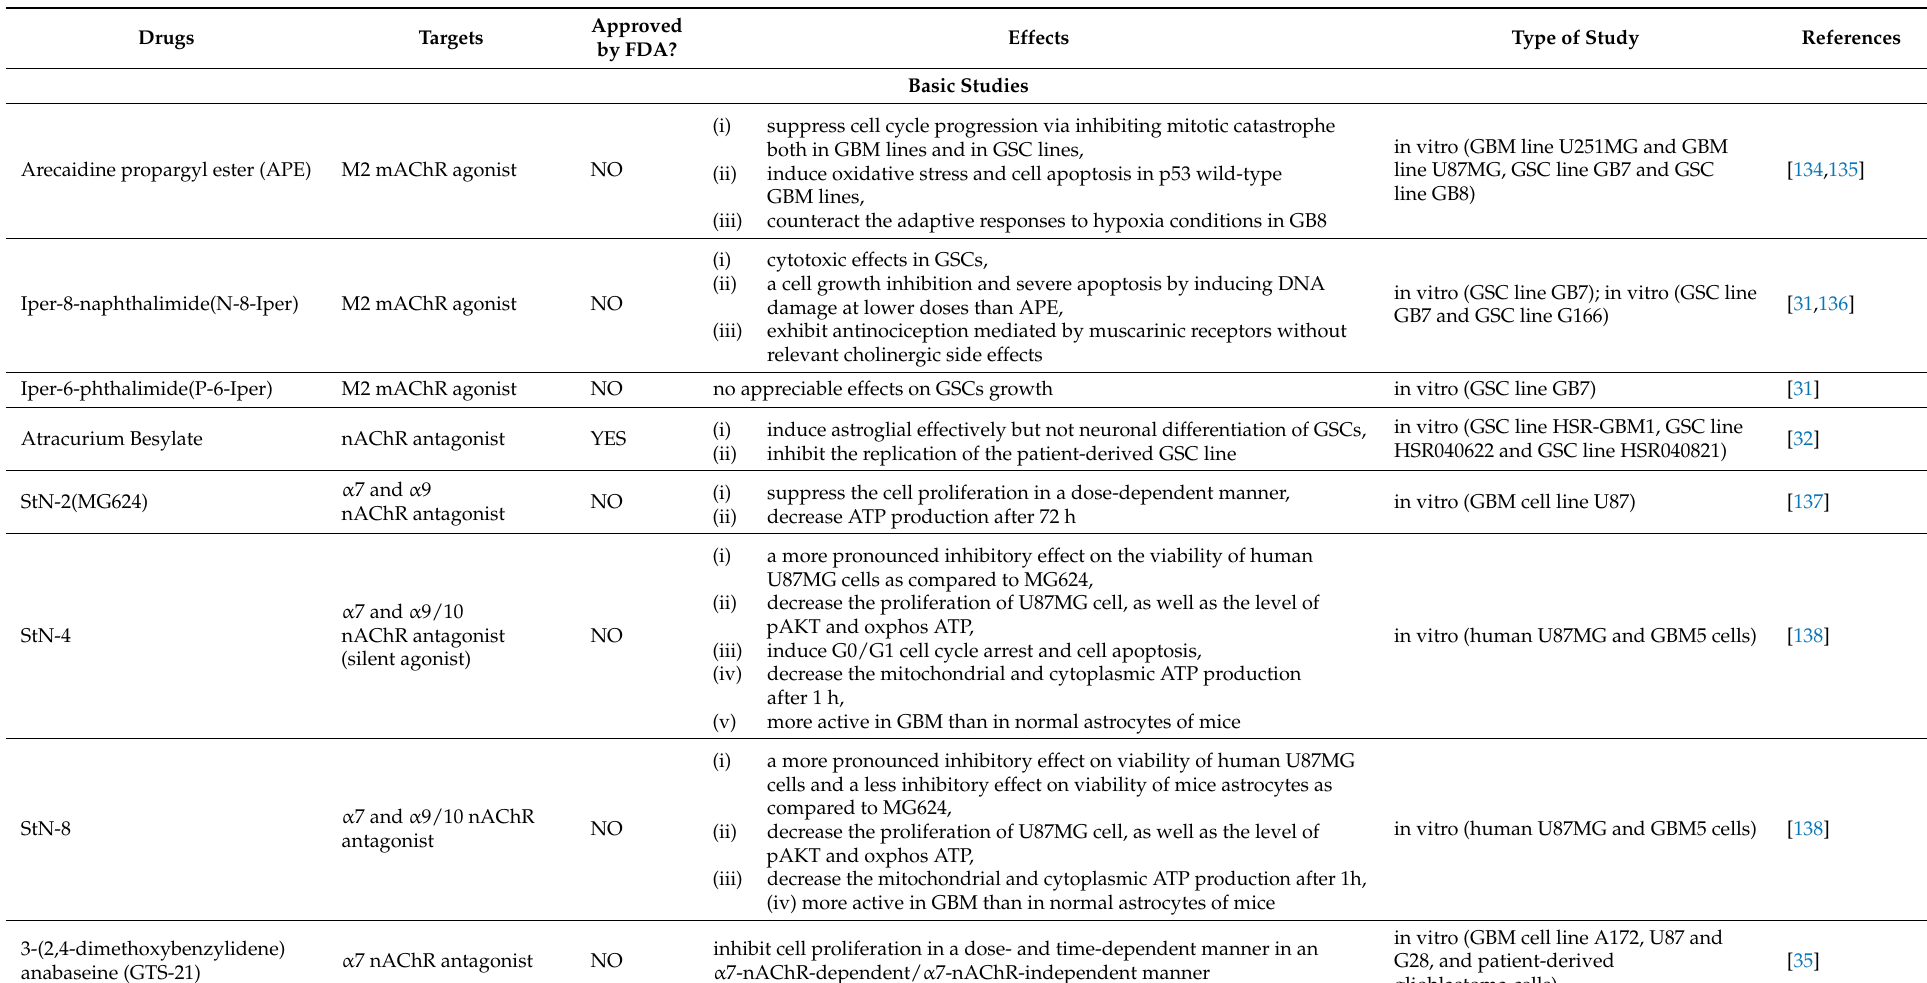
Table 2. Potential effects of drugs targeting neurotransmitters in treating